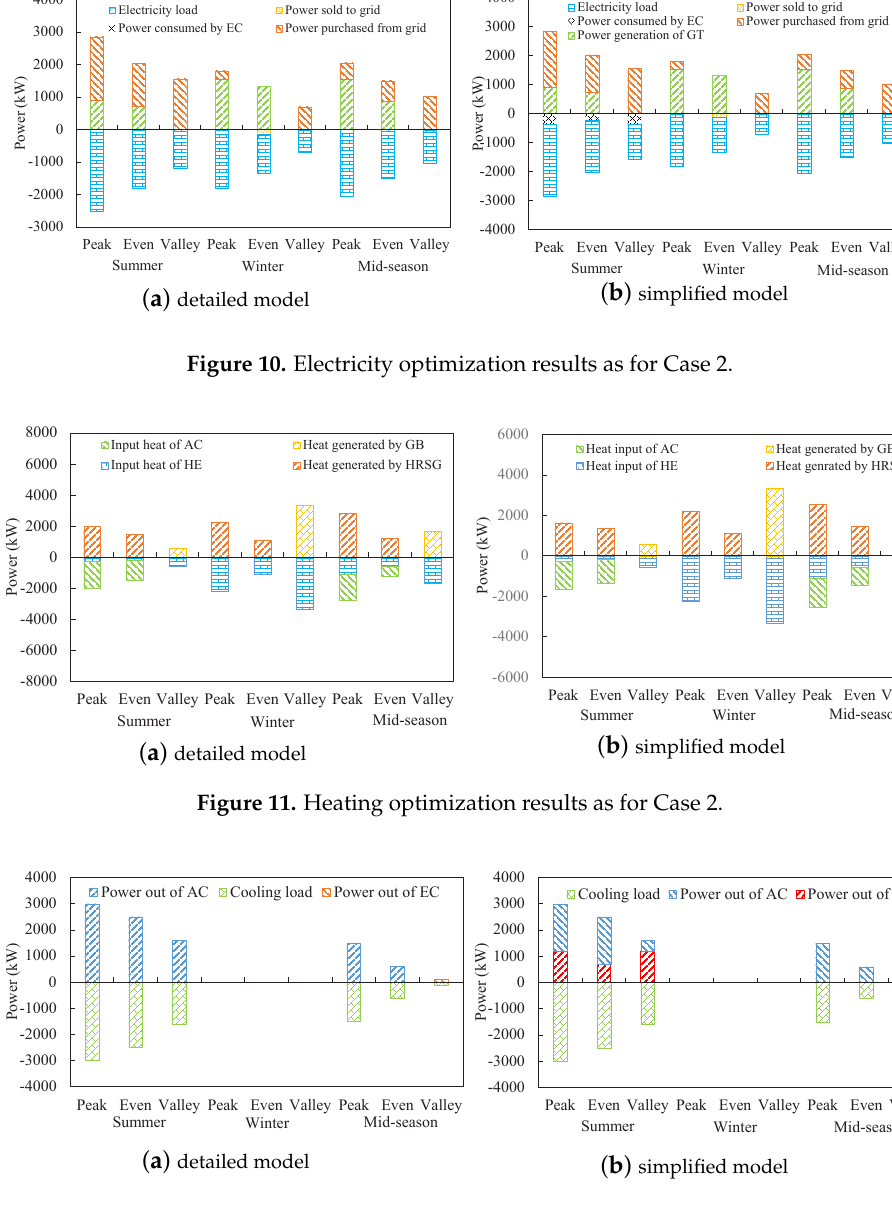
Figure 12. Cooling optimization results as for Case